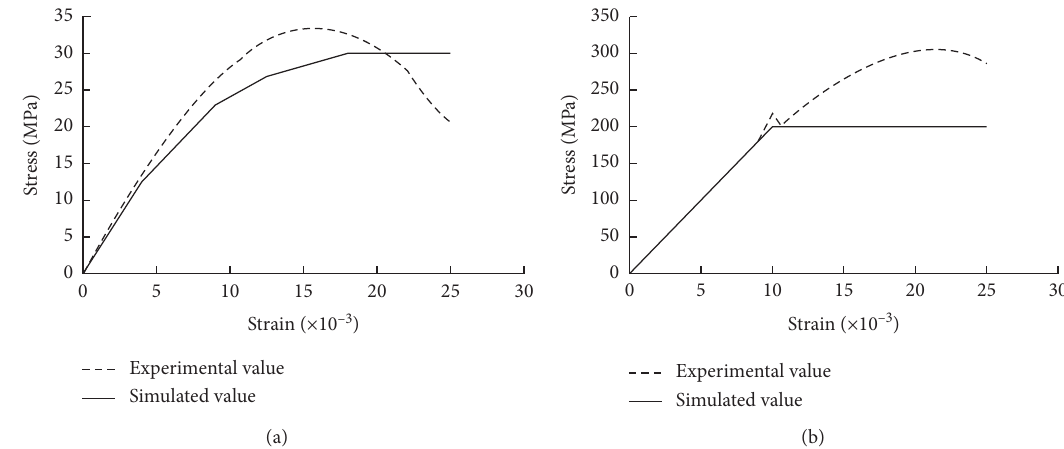
Figure 8: Constitutive model of materials. (a) The constitutive model of concrete. (b) The constitutive model of